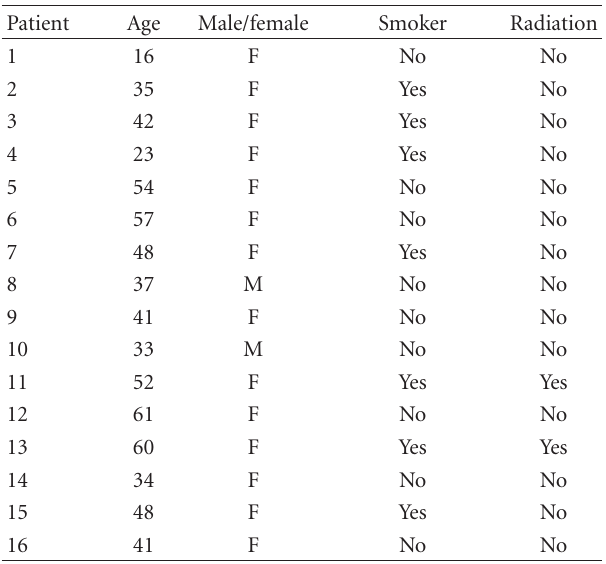
Table 1: Patient